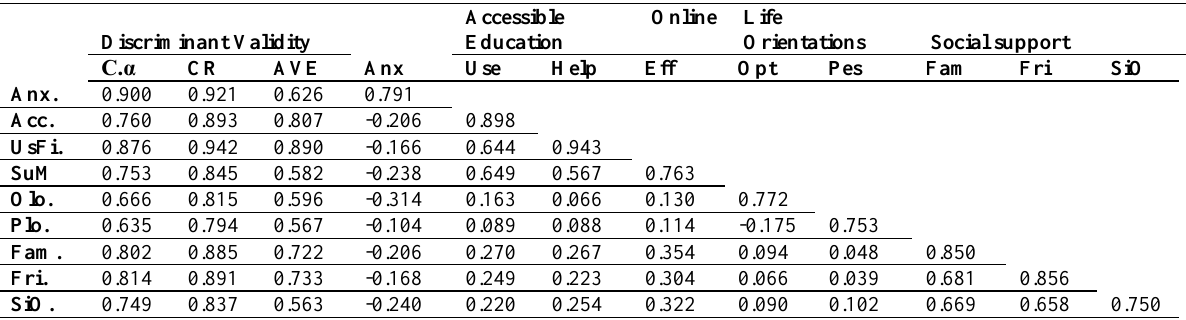
Table 2: Construct Reliability and Discriminant Validity (Internal consistency, Construct validity, and Discriminant Validity Test